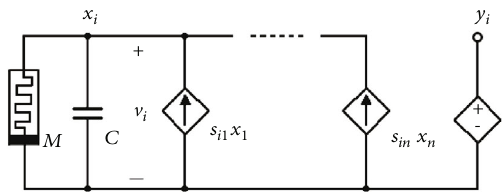
Figure 1: A memristor-based CNN